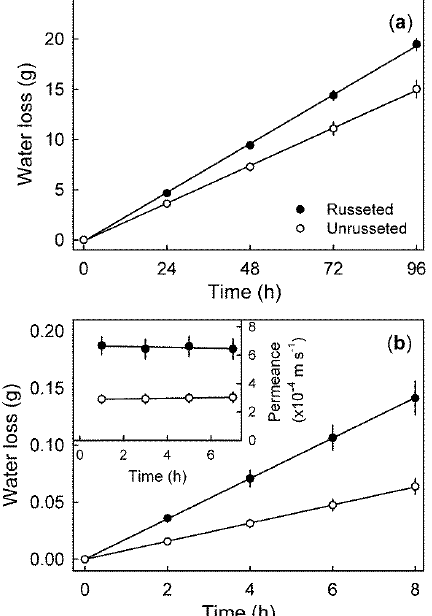
Figure 6. Time course of transpiration by whole fruits with extreme (>50%) (russeted) and with minimal (<25%) russet (not russeted) ( a ) and through epidermal sections (ES) excised from the cheek of mature ‘Apple’ mango fruit with and without russeting ( b ). Permeance of water vapour diffusion through the ES ( b inset ) was calculated under conditions of steady state water loss. Data represent means ± SE of a minimum of 10 replicates.